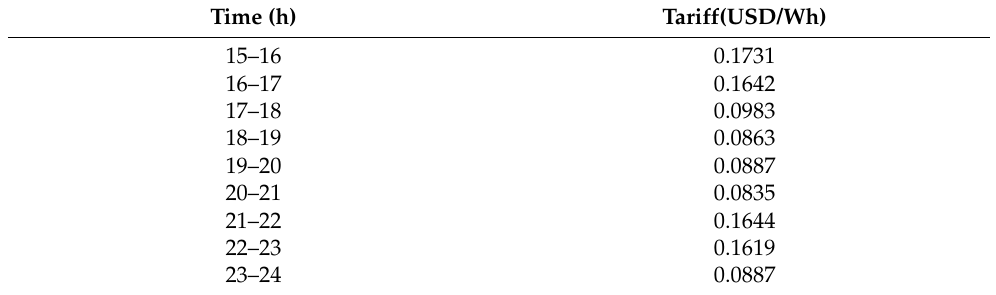
Figure 6. Demand curve of commercial load. Figure 7. Demand curve of industrial load. The ON/OFF period of individual devices of all three areas is shown in Figures 8–10. From Figure 8, the fan operated for a maximum duration and the iron box operated for a minimum duration, while the rest of the devices operated according to the requirement of the user in the residential area. From Figure 9, the air conditioner operated during the nights in the summer, while the rest of the devices operated according to the requirement